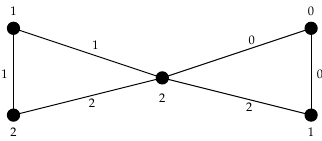
Figure 16. 3-TEMC labeling of F